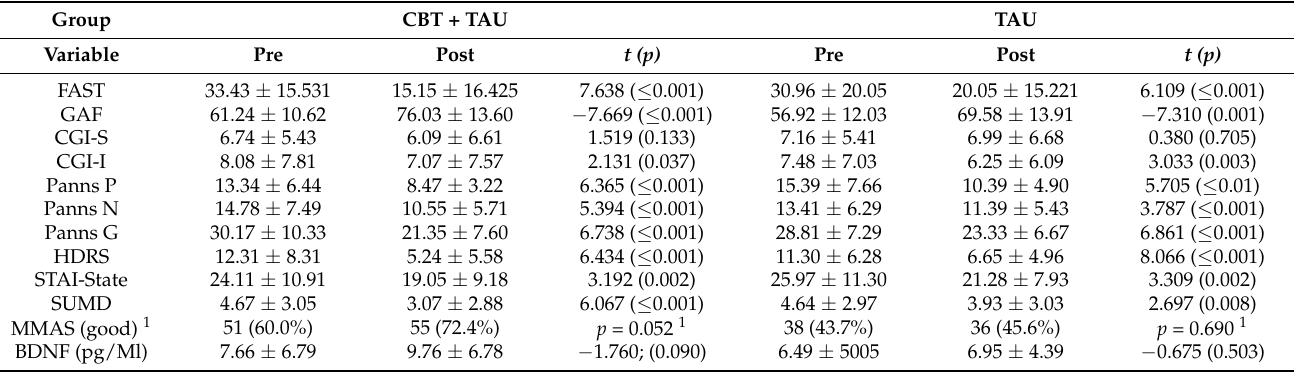
Table 2. Within-group changes